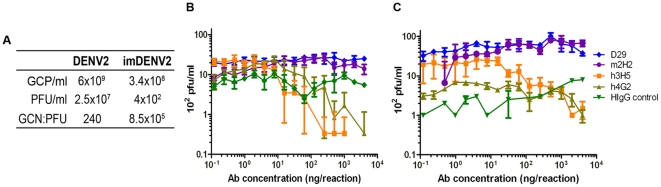
Effect of DENV maturation state on ADE profile by D29 Fab-IgG.(A) The specific infectivity of DENV2 and imDENV2 was determined. Serially diluted anti-DENV antibodies were incubated with (B) DENV2 or (C) imDENV2 at MOG 25 for 1 hr at 37oC before infection of 2×104 K562 cells for 2 days. Viral titer was quantified by plaque assay (limit of detection is 0.5×102 pfu/ml). Data presented is the average of three independent experiments with error bars representing the standard deviation.